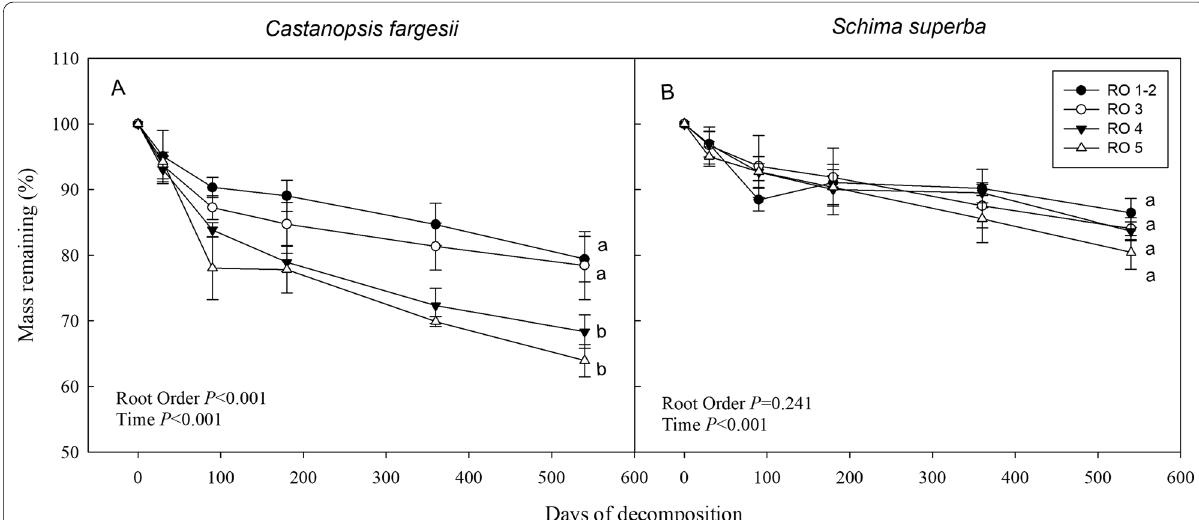
Fig. 2 Mass remaining (%) during the 540-day decomposition for roots of different branch orders of the two species. RO1–2 refers to the 1st- and 2nd-order roots, RO3, RO4 and RO5 refer to the 3rd, 4th and 5th-order roots, respectively. Error bars represent to compare the differences between roots of different branch orders with decomposition time as the covariate. Different letters at the end of the curves indicate significant differences between two root-order classes ( P